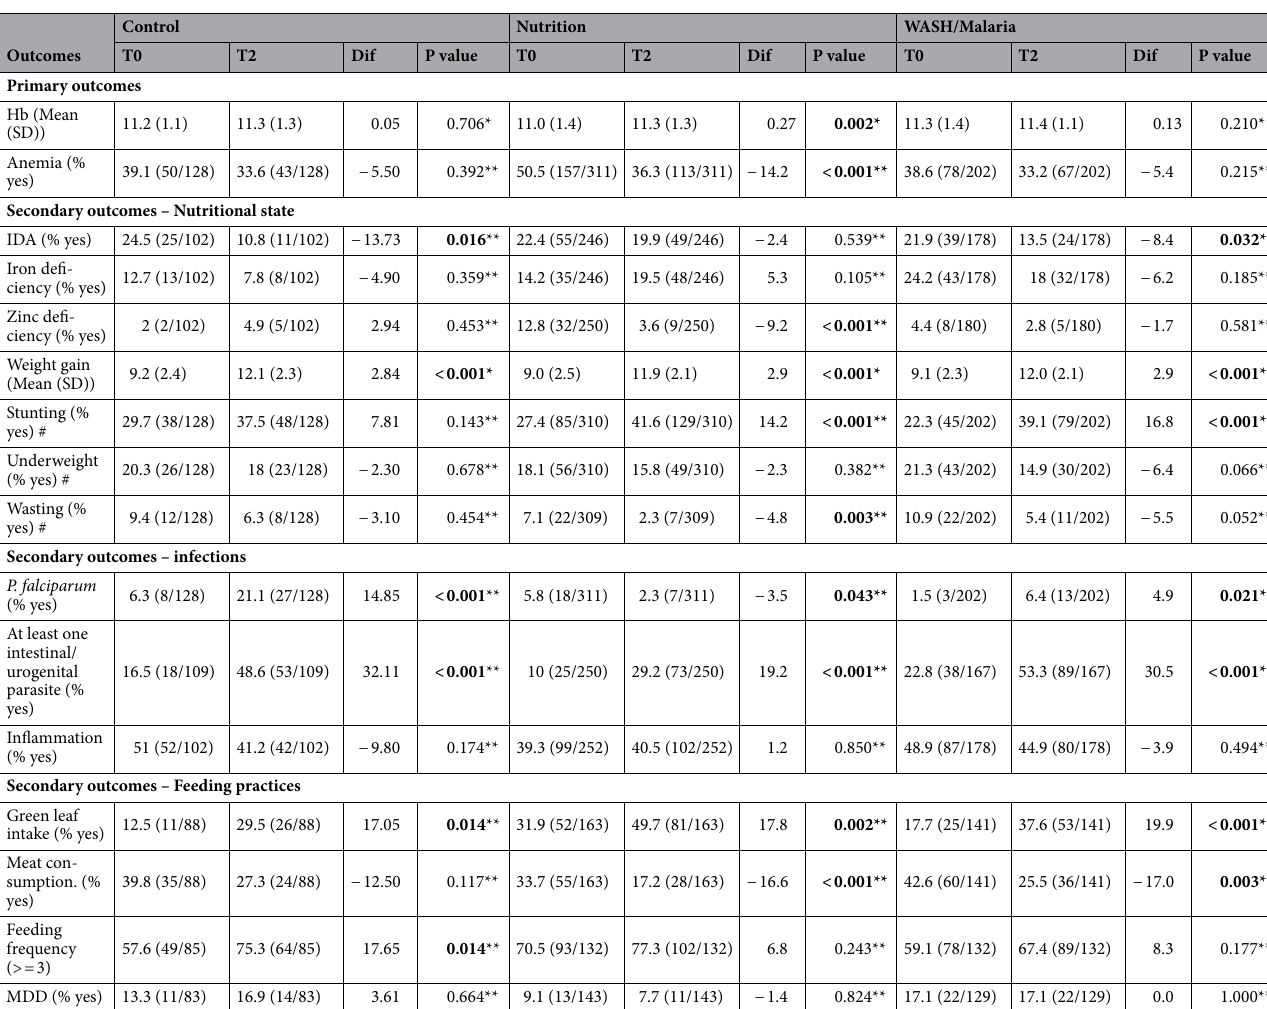
Table 2. Variation in the primary and secondary outcomes among children completing the study, between the baseline and 12-month follow up. SD – Standard deviation, Hb – Hemoglobin, MDD – Minimum Dietary Diversity * Students’ t, ** McNemar Test. Bold is highlighting statistically significant P